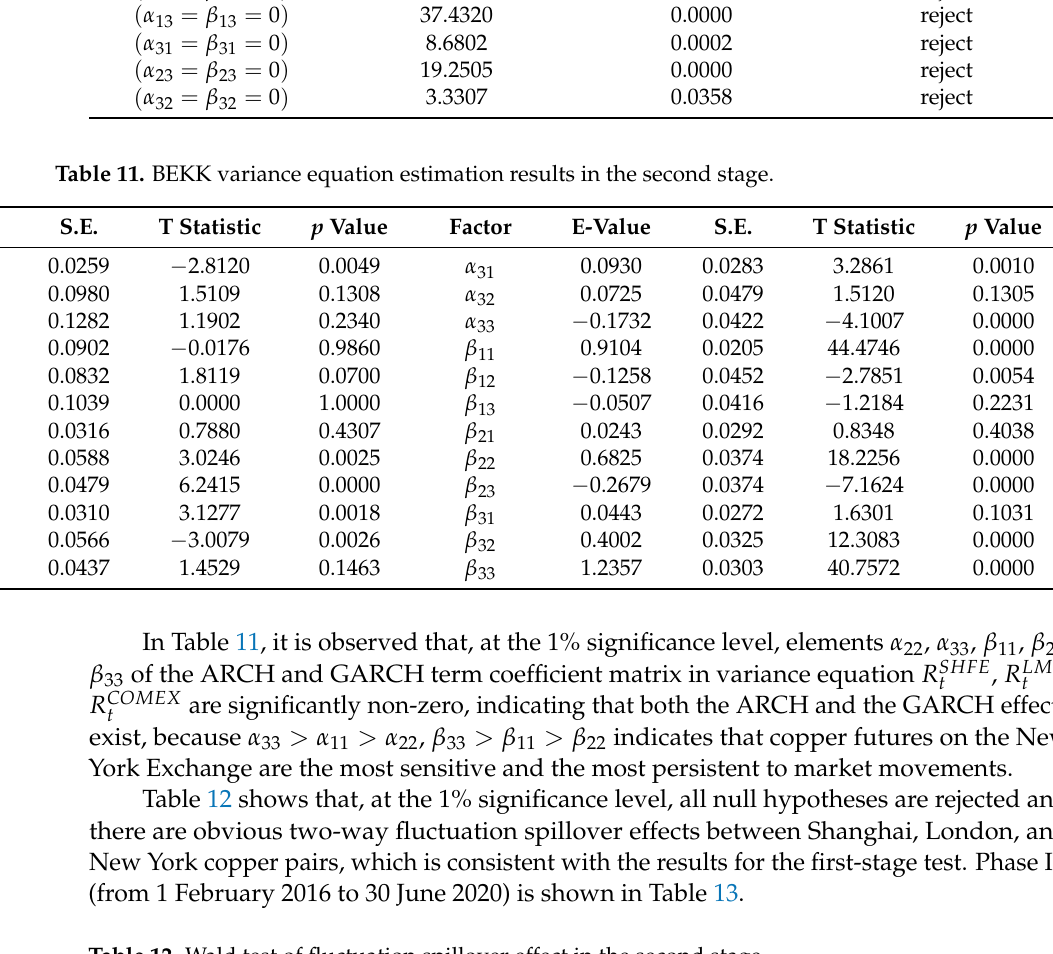
Table 12. Wald test of fluctuation spillover effect in the second